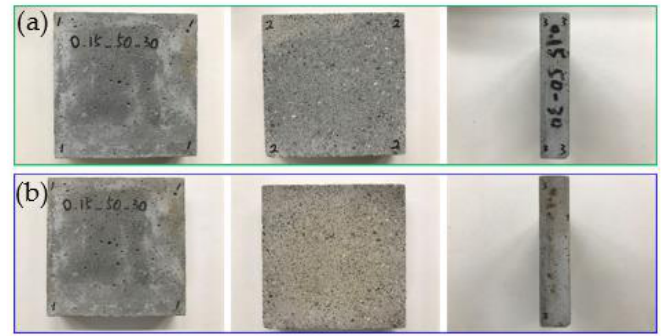
Figure 10. #40 − 50 − 30 − C/S= 0.15. ( a ) Before testing. ( b ) After testing.